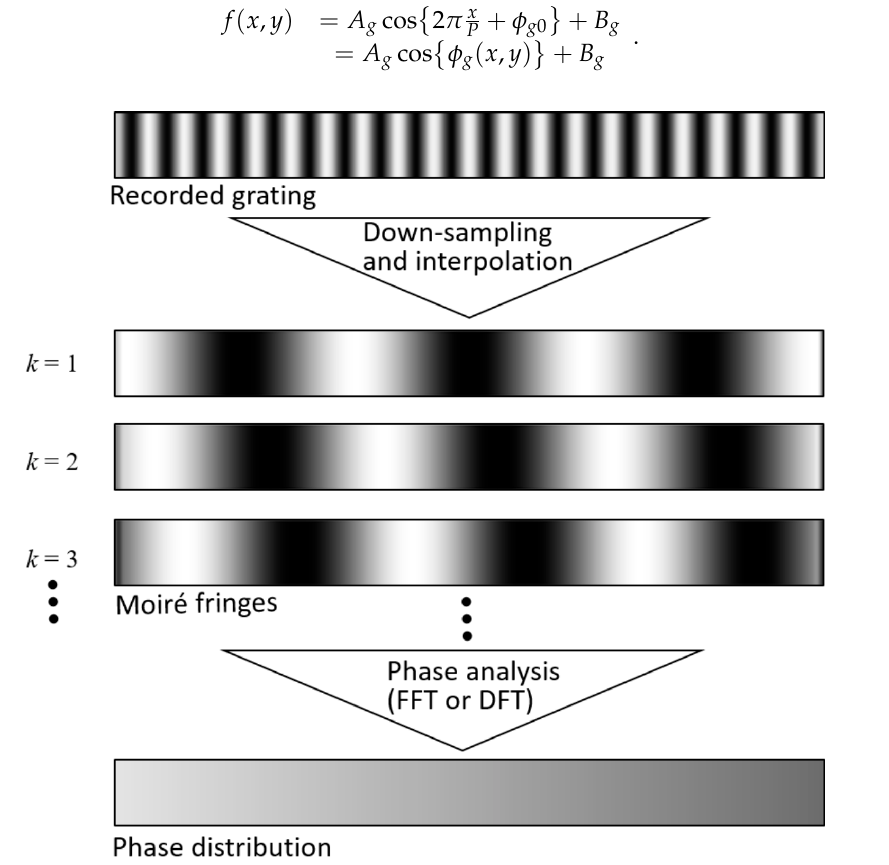
Figure 2. Principle of the sampling Moiré technique to calculate the phase distribution from a single grating pattern. FFT denotes the fast Fourier transform and DFT denotes the discrete Fourier transform.